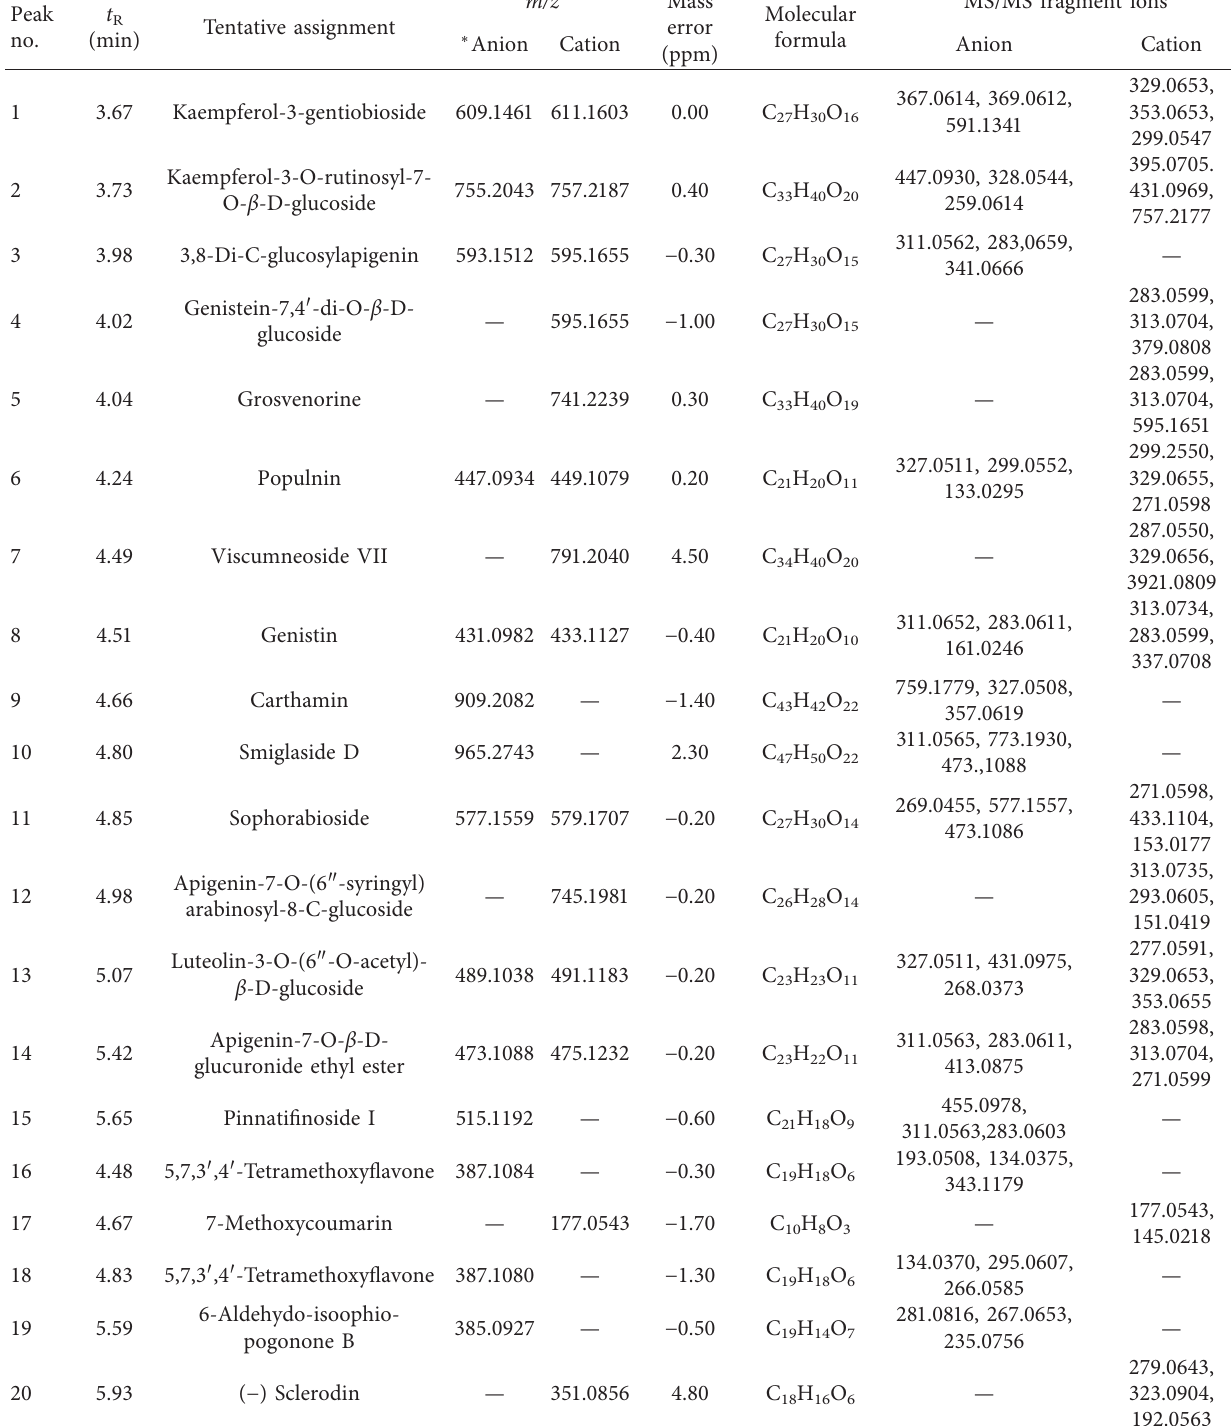
Table 2: Characterization of major compounds identified in soluble and bound